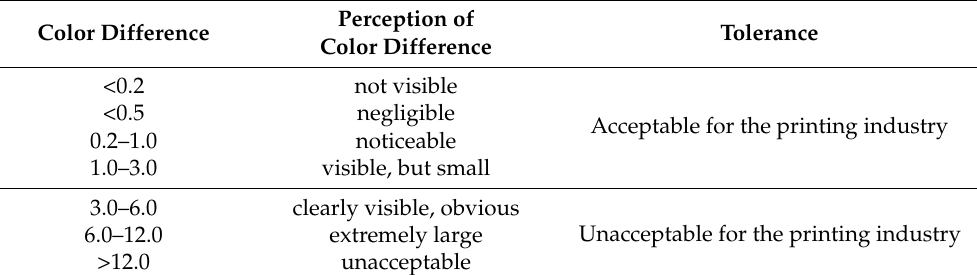
Table 4. Subjective assessment metric based on CIEDE2000 Color difference [47,49].